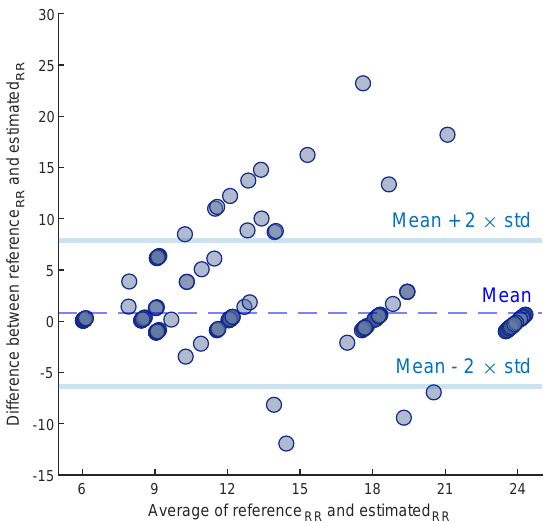
Figure 9. The Bland–Altman plot of the estimated RRs on dataset